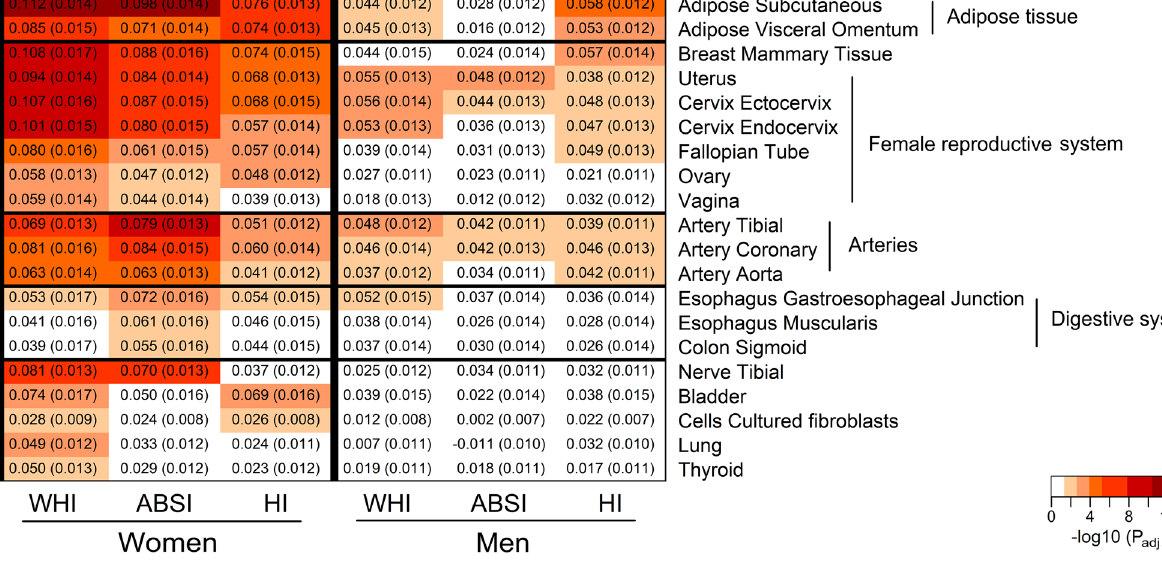
Figure 5. eQTLs associated with allometric body-shape indices. ABSI-a body shape index calibrated for UK Biobank participants (ABSI UKB ); eQTLs-expression Quantitative Trait Loci; HI-hip index calibrated for UK Biobank participants (HI UKB ); WHI-waist-to-hip index calibrated for UK Biobank participants (WHI UKB ). The figure includes specific tissues from the Genotype-Tissue Expression (GTEx) v8.0 database, queried for associations with eQTLs with gene-property analysis, which were identified by MAGMA v1.08 employed in FUMA v1.3.6a as significant for at least one of the allometric indices in women or men, i.e. with adjusted P adj < 0.05, incorporating Bonferroni correction for multiple comparisons for 54 tissues. White cells are tissues with P adj ≥ 0.05 for the corresponding body-shape